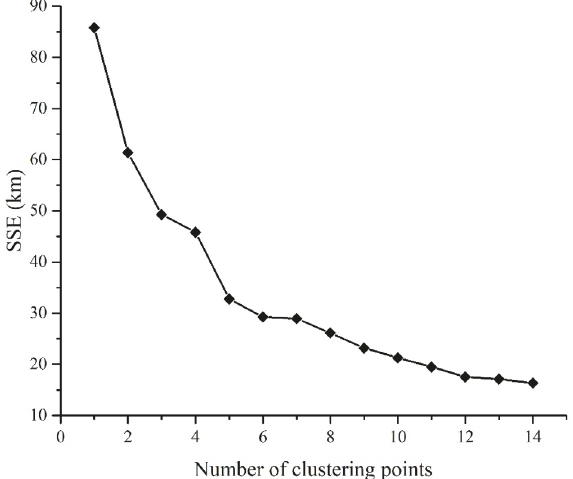
Figure 5: The SSE graph of